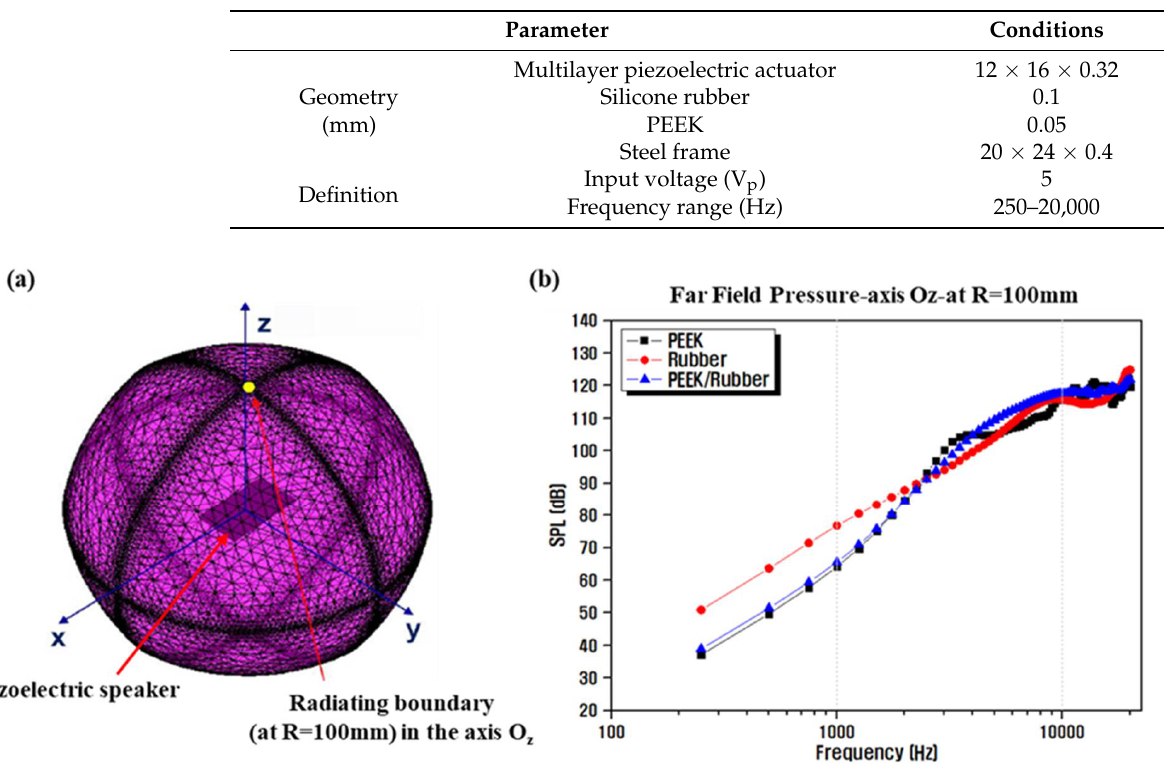
Figure 7. Simulated frequency responses of piezoelectric speakers constructed using acoustic diaphragm structures of different sizes.